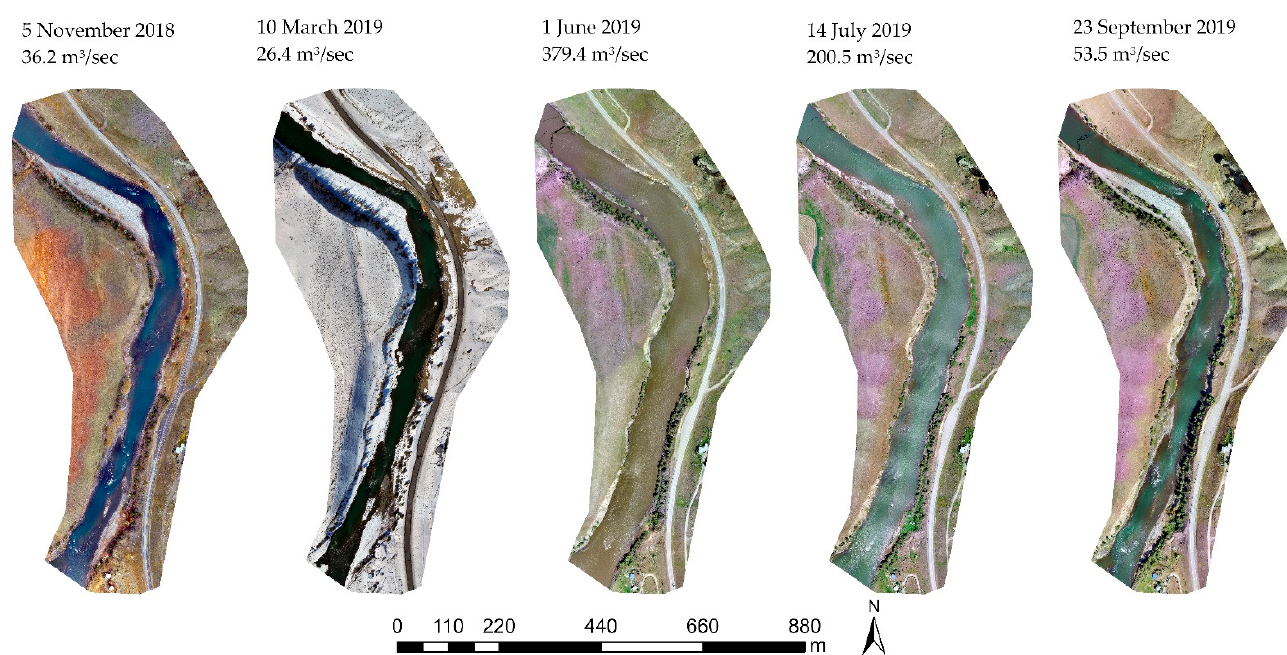
Figure 6. Orthomosaics generated from RGB images with survey date and Yellowstone River flow rate. Table 3. Summary of number of images processed, area covered, median keypoints per image, percent calibrated images and median matches per image for every thermal orthomosaic SfM model. Median values are calculated for full flight image processing.